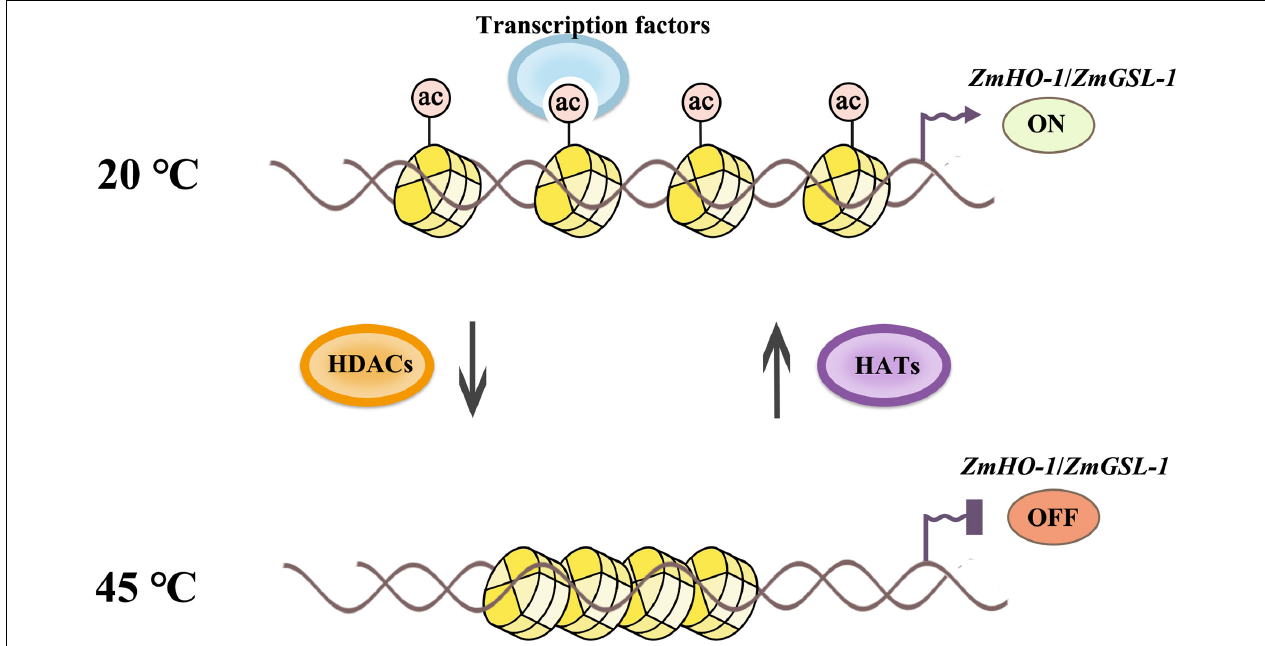
FIGURE 9 | Schematic representation of histone acetylation regulation in lateral root development under heat stress. Histone acetylation level of ZmHO-1 and ZmGSL-1 gene promoter region were decreased under heat treatment. The lower acetylated histone apparently highly charged and binds with DNA phosphate backbone closely. The transcription factor and RNA polymerase II might not access DNA, therefore inhibited transcription, subsequently led to the lateral root abnormality in maize.